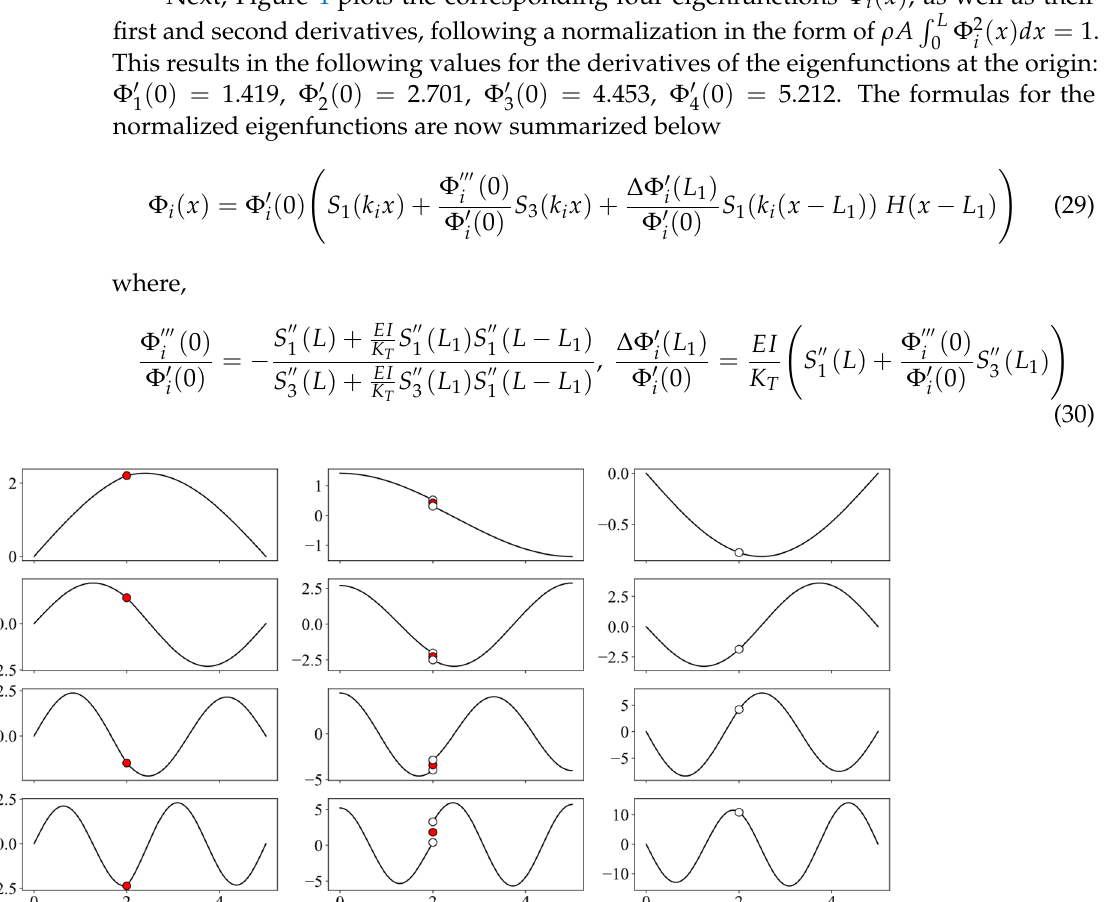
Figure 4. Normalized eigenfunctions for a simply supported beam of length L = 5 m, cross-section dimensions b = 0.20 m, h = 0.05 m and a spring value K T = 1573.6 kNm/rad representing a vertical crack of length α = 25 mm at station L 1 = 2.00 m. The first column is for eigenfunctions 𝛷 (cid:3036) (𝑥) , the second column is for the first derivatives 𝛷 (cid:3036)(cid:4593) (𝑥) and the third column is for the second derivatives 𝛷 (cid:3036)(cid:4593)(cid:4593) (𝑥) .